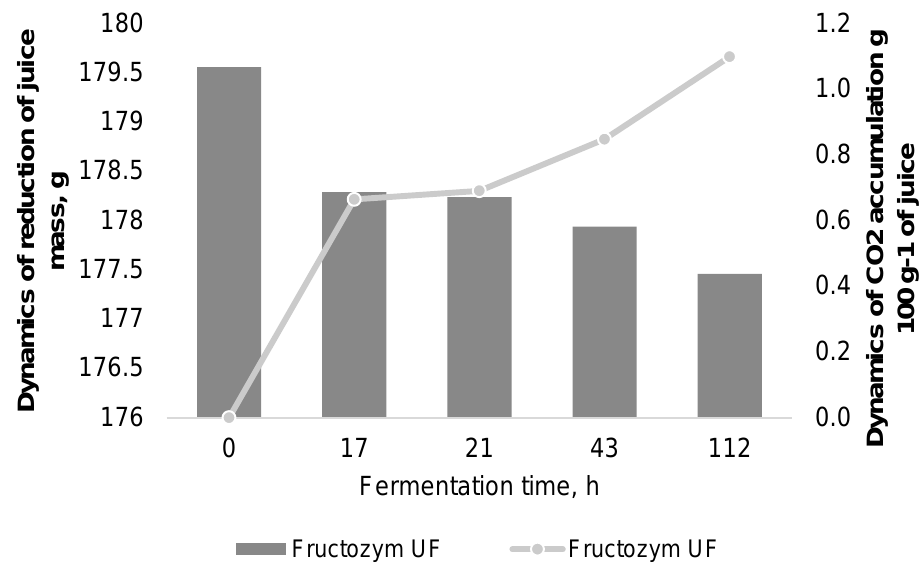
Figure 3. Dynamics of fermentation of hogweed juice using Fructozym UF.